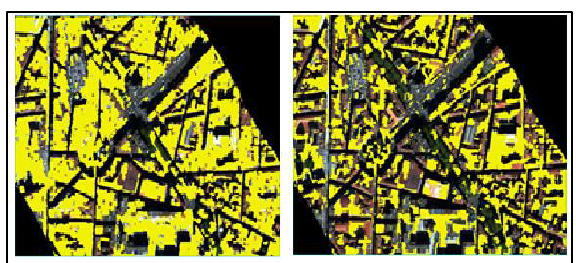
Figure 5. Urban objects identification using spatial attribute (length) with 2 different data range thresholds